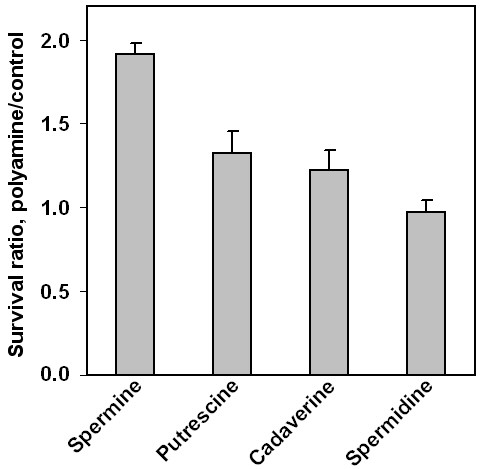
Extreme-acid survival in the presence of polyamines. The mean survival at pH 2 after 2 h in the presence of each polyamine (10 mM) was divided by the mean survival of a sample diluted from the same overnight culture without exogenous polyamines. The mean of six independent cultures is shown, +/- SEM.